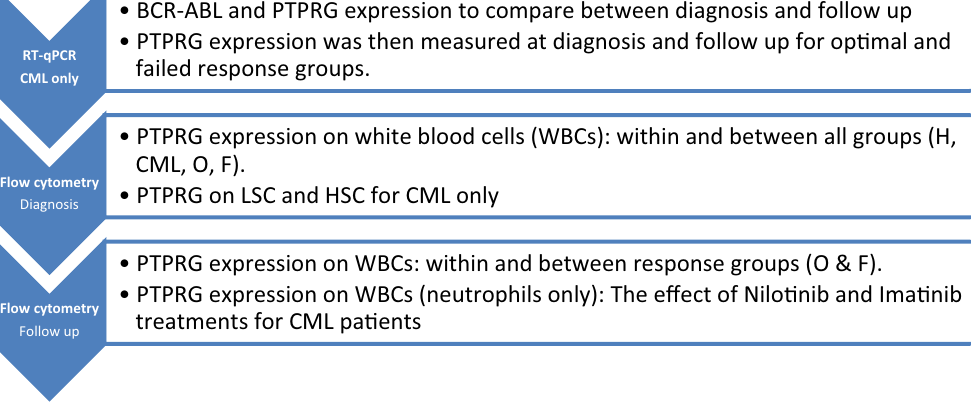
Figure 1. Presentation of